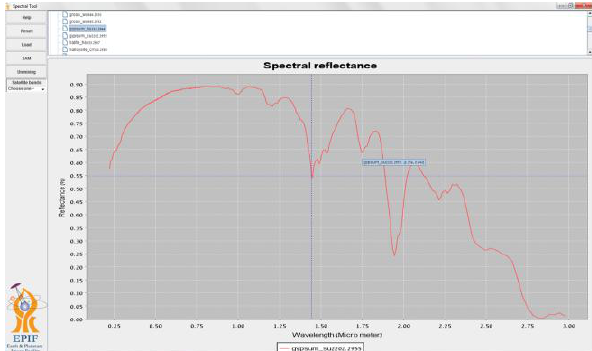
Figure 3. Display of Gypsum_su2202.2955. the blue coordinate system hinges allow precise visual examination of the reflectance wavelength for each